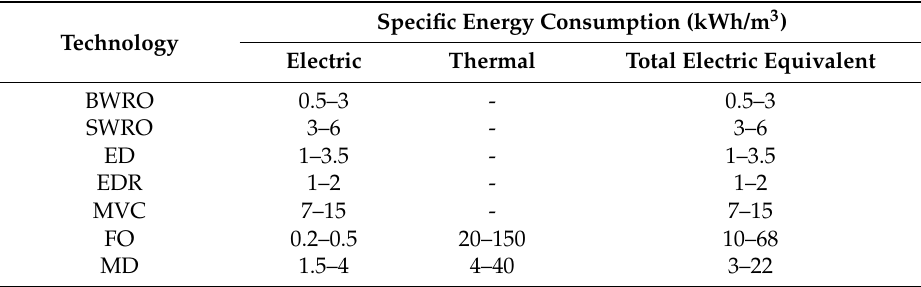
Table 1. Specific energy consumption (SEC) by different desalination techniques